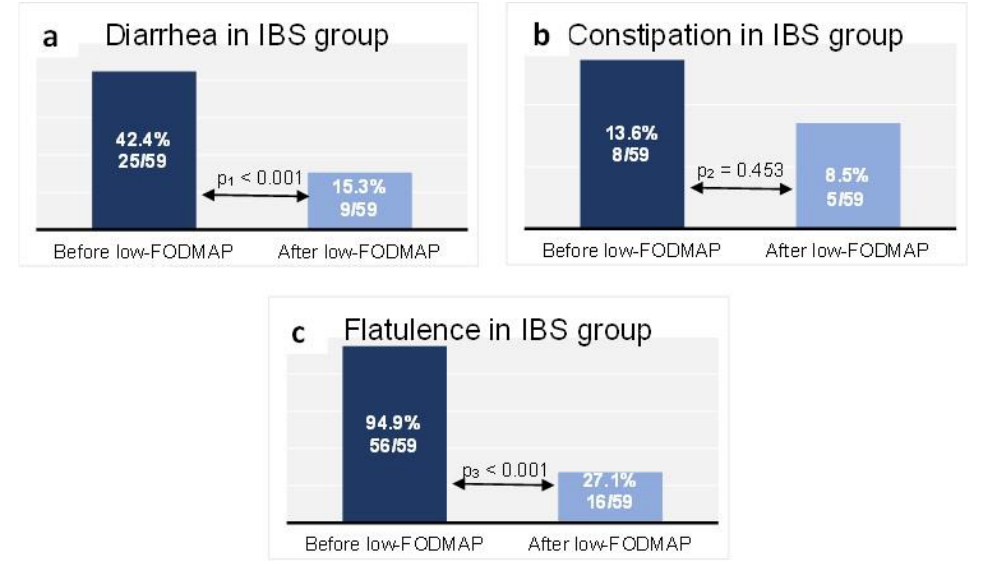
Figure 3. Proportion of the IBS group reporting diarrhea ( a ), constipation ( b ) and flatulence ( c ) at baseline and at the end of follow-up. Data are presented as n (% of total group). McNemar test: p 1 < 0.001, p 2 = 0.453, p 3 < 0.001.